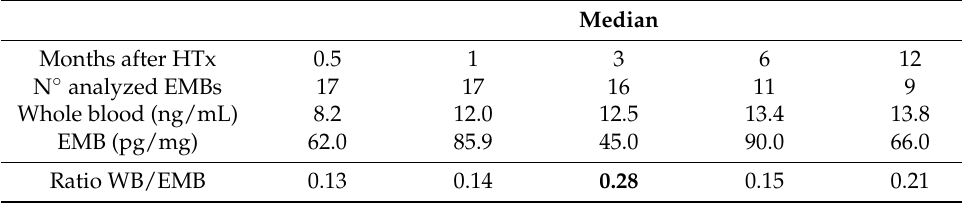
Table 3. Tacrolimus concentration–time profiles in whole blood and EMBs.